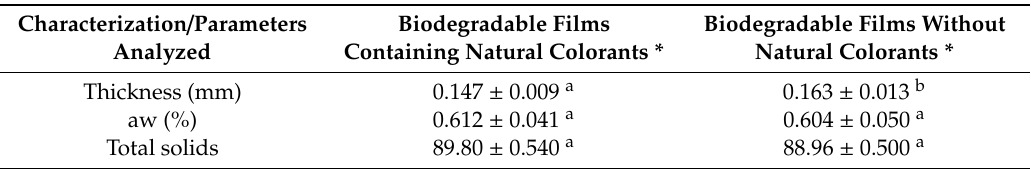
Table 2. Characterization of biodegradable films in the presence or absence of natural colorants in terms of thickness, water activity (aw), and total